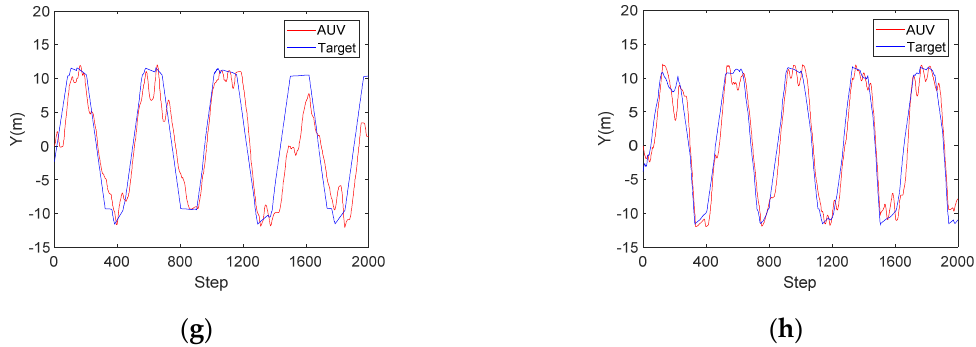
Figure 6. The coordinate change curves in Scene 1 during the process of AUV tracking the target using PPO, SAC, GAIL, and MAG, respectively: ( a – d ) the X-coordinate change; ( e – h ) the Y-coordi- nate change.